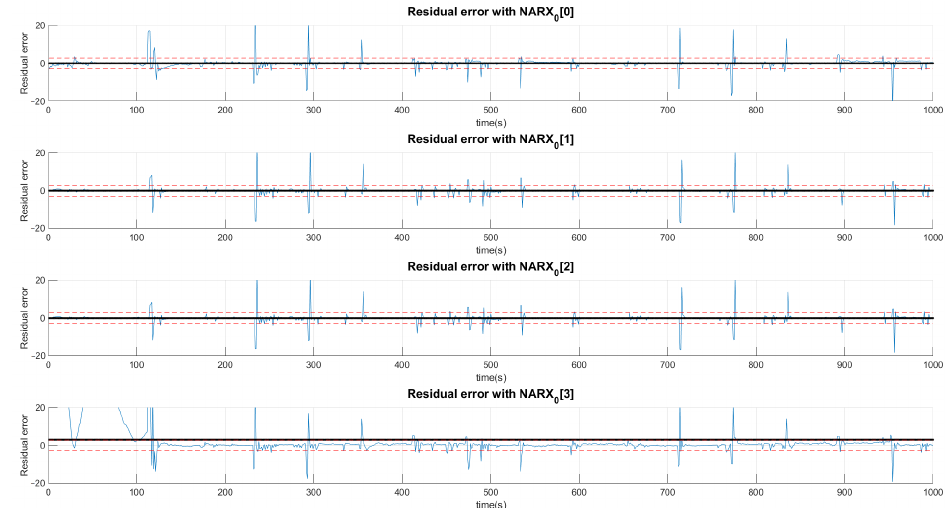
Figure 11. Production of plant residues for the networks expert to detect no presence of faults (NARX 0 [0]) and for NARX expert to Faults F1, F2 and F3. All of these are produced in the first layer (Layer 0) of the decision tree.